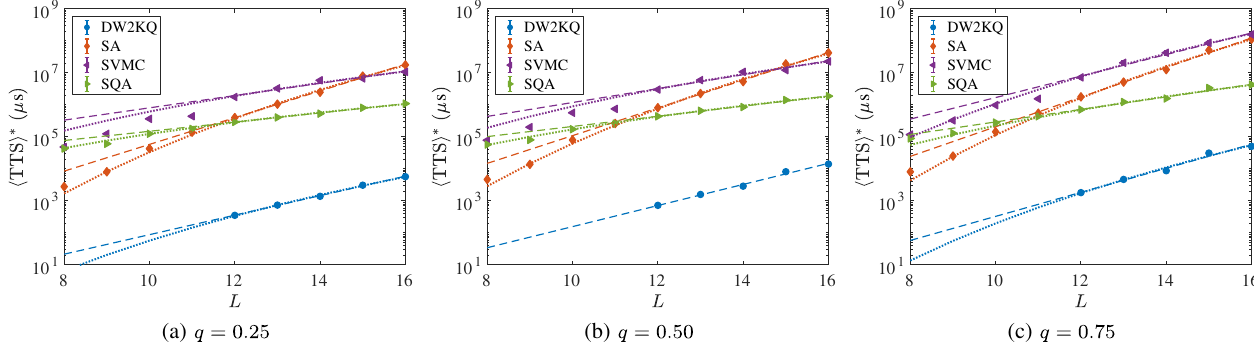
FIG. 2. Scaling of the optimal TTS with problem size. Result shown are for the logical-planted instance class. The data points represent the DW2KQ (blue circles) and three classical solvers: SA (red diamonds), SVMC (purple left triangles), and SQA (green right triangles) algorithms. The dashed and dotted curves correspond, respectively, to exponential and polynomial best fits with parameters shown in Fig. 3 (also given in table format in Table III in the Appendix). Panels (a) – (c) correspond to the 25th quantile, median, and 75th quantile, respectively. SVMC and SQA were run with β ¼ 2 . 5 here. Additional simulation parameters for SA, SVMC, and SQA algorithms are given in Appendix C. The data symbols obscure the error bars, representing the 95% confidence interval for each optimal TTS data point [computed from the fit of ln h TTS i to a quadratic function, as explained in Appendix K].